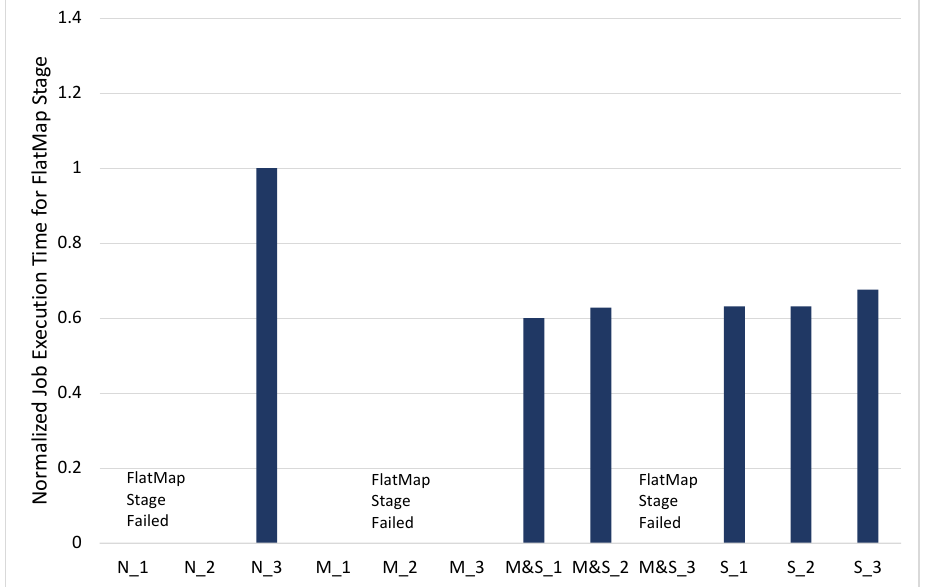
Figure 6. The normalized PageRank job execution time for 1 GB